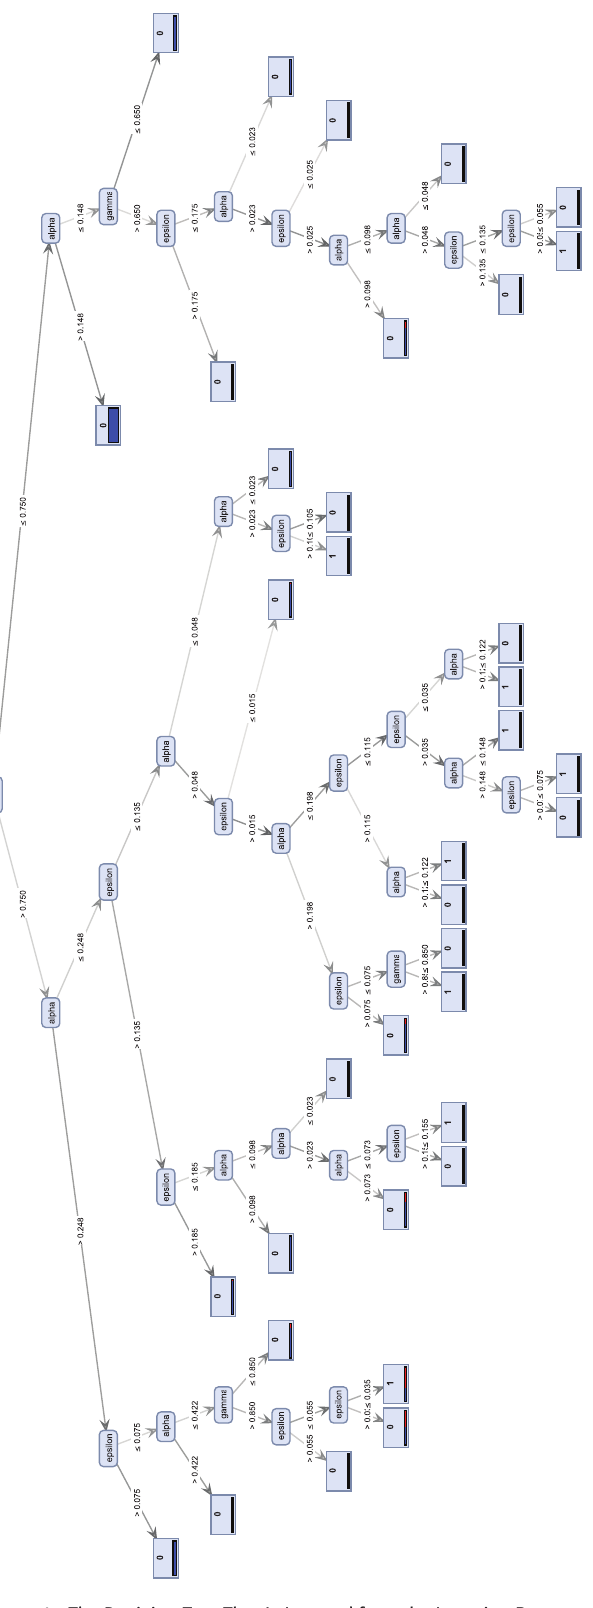
Figure 1: The Decision Tree That Is Learned from the Learning Parameters Data Set. The majority of the paths lead to defection (class 0). Only 9 (out of 36) paths in the tree lead to